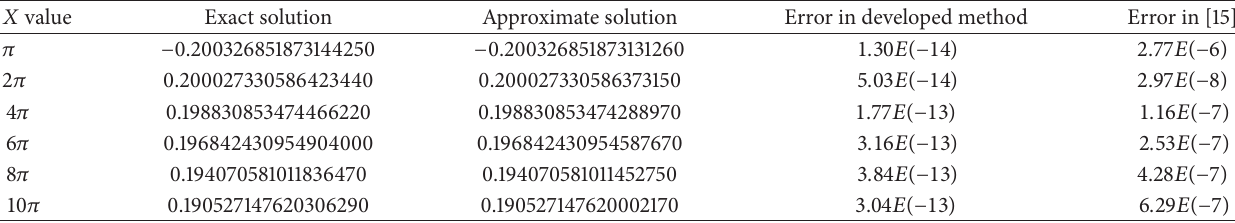
Table 6: Comparison of the proposed method with